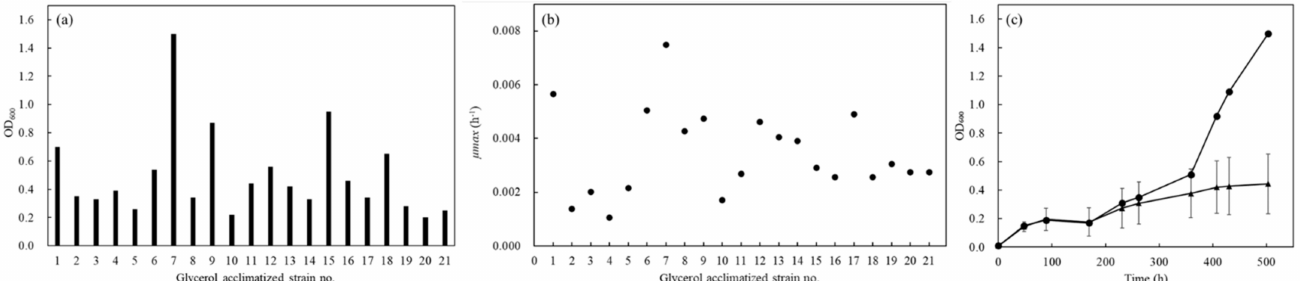
Figure 2. Growth profile of glycerol-acclimatized strains on YNBG medium after selection from the YNBG plate. ( a ) Growth of glycerol-acclimatized strains was evaluated with the OD 600 value after 503 h cultivation in YNBG medium; ( b ) µ max of each glycerol-acclimatized strain in YNBG medium was displayed; ( c ) growth profiles of glycerol-acclimatized strains were evaluated using each OD 600 value. The growth profiles are shown as symbols of circles (no.7) and triangles (averaged growth of glycerol-acclimatized strains without no.7). Error bars indicate standard deviation of OD 600 of glycerol-acclimatized strains without no.7. The growth profiles in YNBG were used for the primary